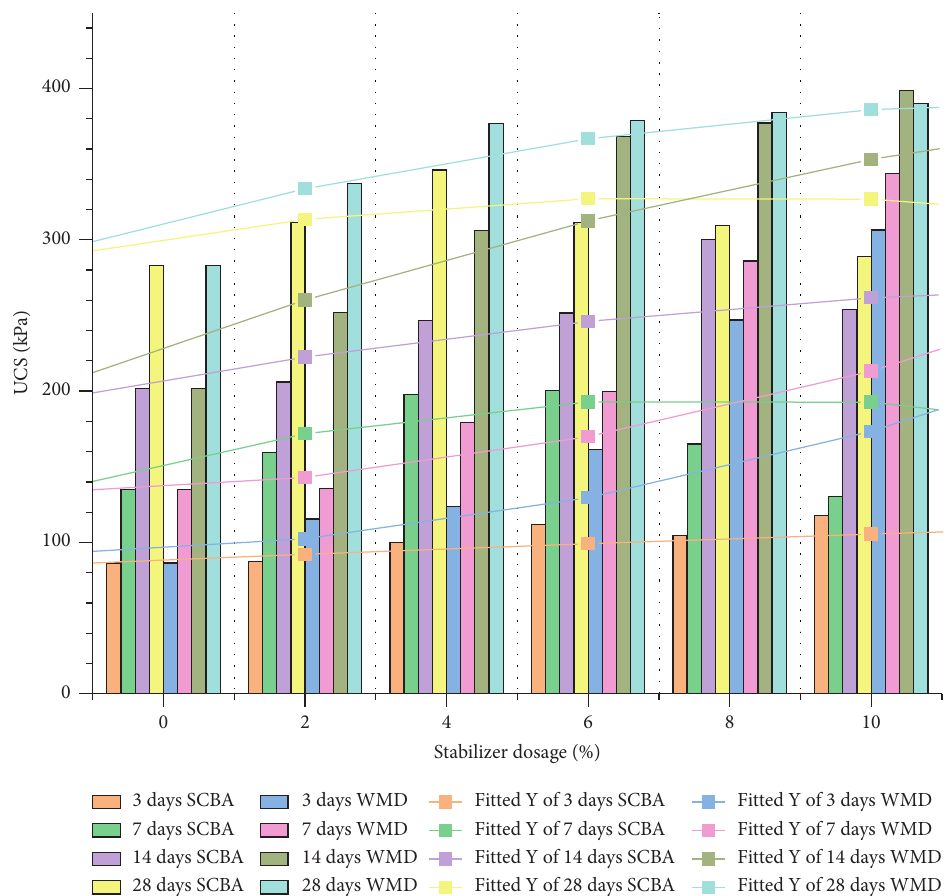
Figure 12: Effect on unconfined compression strength at various curing ages after addition of